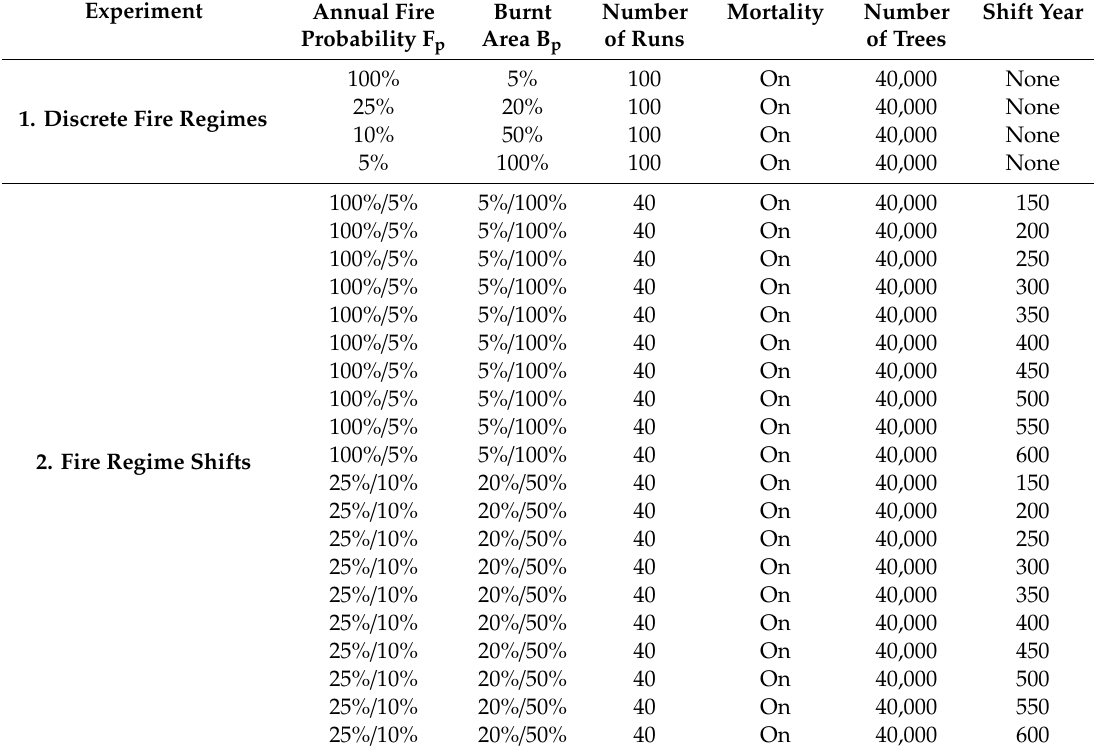
Table A3. List of simulation experiments